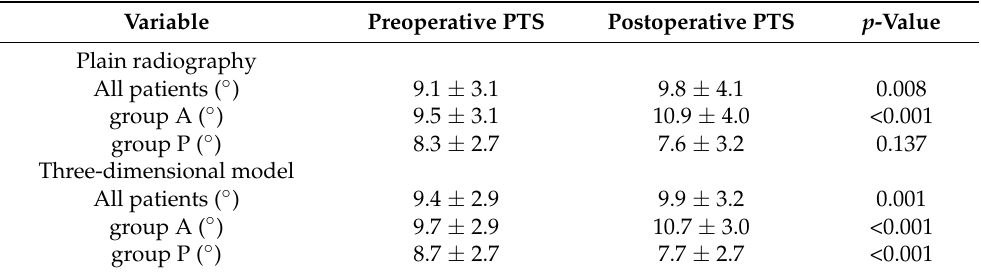
Table 3. Comparison between preoperative and postoperative measurement of posterior tibial slope on the plain radiograph and three-dimensional model.